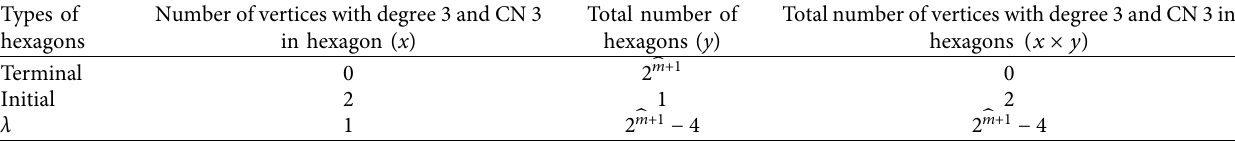
Table 5: Total number of vertices with degree 3 and CN 3 in ζ .